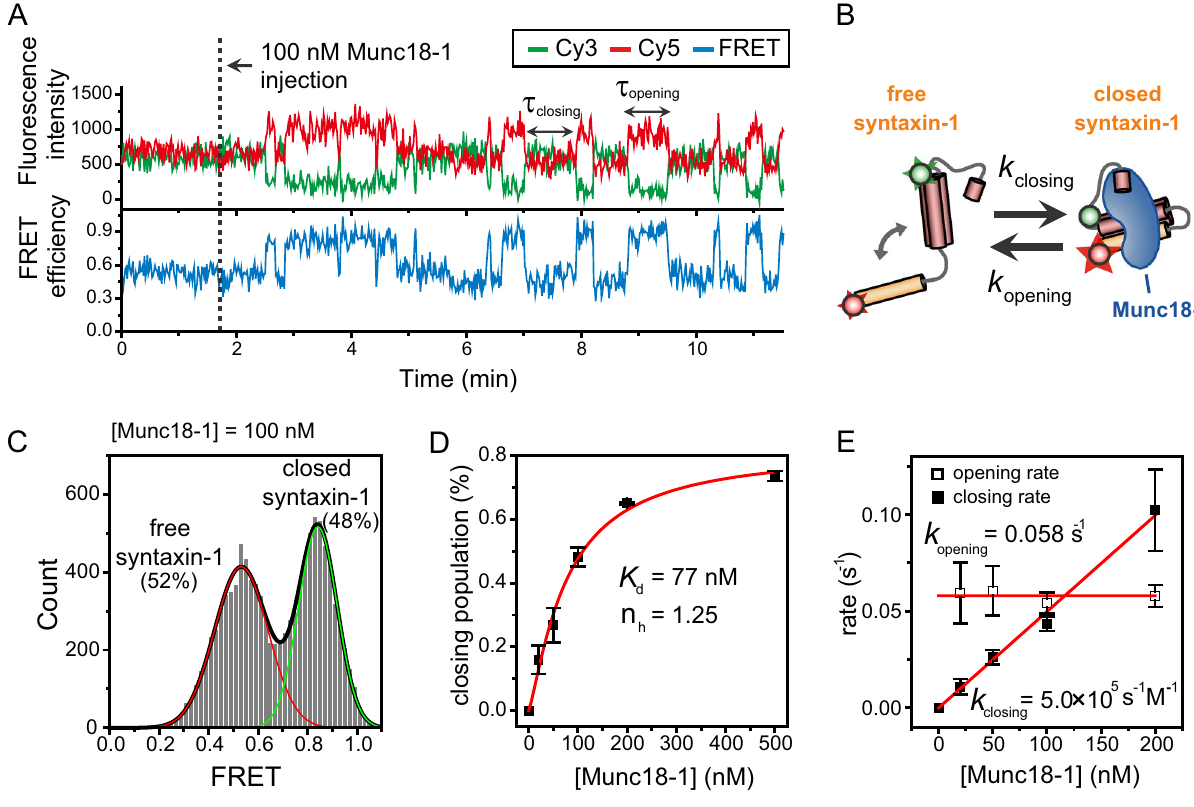
Figure 2. Kinetic analysis of the closing and opening of syntaxin-1 by Munc18-1. ( A ) Representative time traces of fluorescence intensity and FRET efficiency showing the closing and opening of syntaxin-1 by Munc18- 1. Cy3 fluorescence, Cy5 fluorescence, and corresponding FRET efficiency are shown in green, red, and blue, respectively. This same color convention is used throughout the paper. τ closing (or dwell time of open syntaxin-1) indicates the time for syntaxin-1 to undergo a conformational change from the open to the closed state, while τ opening (or dwell time of closed syntaxin-1) indicates the time for the opposite case. ( B ) Kinetic scheme for the Munc18-induced syntaxin-1 closing/opening reaction. ( C ) FRET histograms of syntaxin-1 in the presence of 100 nM Munc18-1. Relative populations for each state were obtained by fitting the FRET histogram to sum of two Gaussian functions. ( D ) Relative population of the closed syntaxin-1 conformation at varying Munc18-1 concentrations. The dissociation constant and hill coefficient of the Munc18-1 were obtained from a hyperbolic Hill fit of the data. ( E ) Closing and opening rates at varying Munc18-1 concentrations. The closing rate constant (5.0 × 10 5 s −1 M −1 ) was obtained from a linear fit of the data. The average of opening rates is 0.058 s −1 . Error bars in ( D , E ) represent standard deviations obtained from two independent